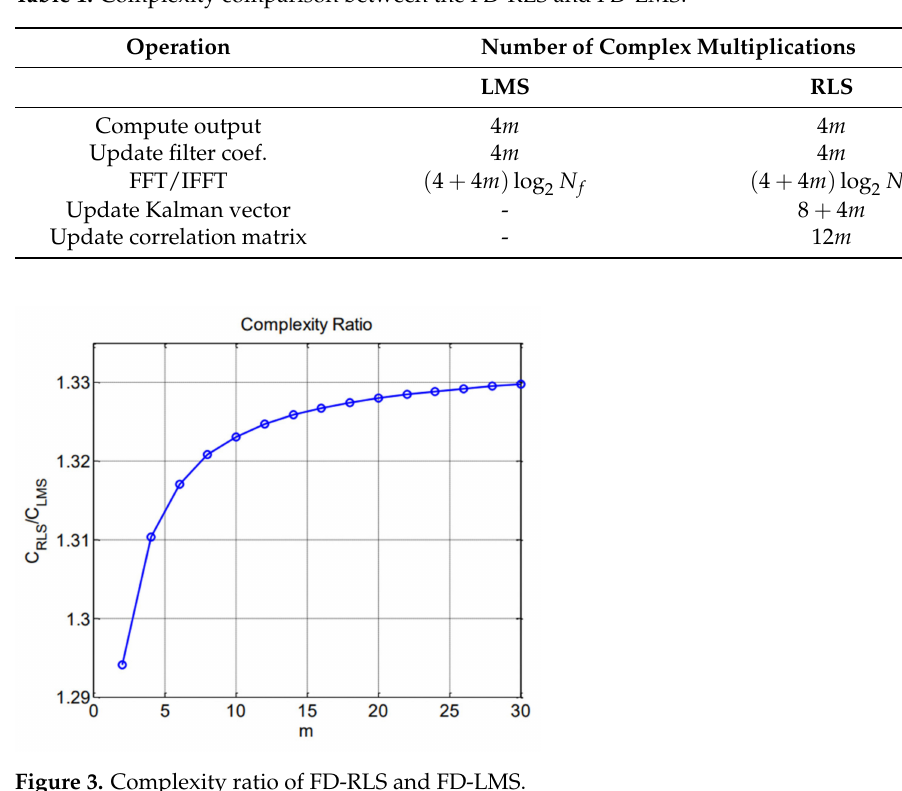
Figure 3. Complexity ratio of FD-RLS and